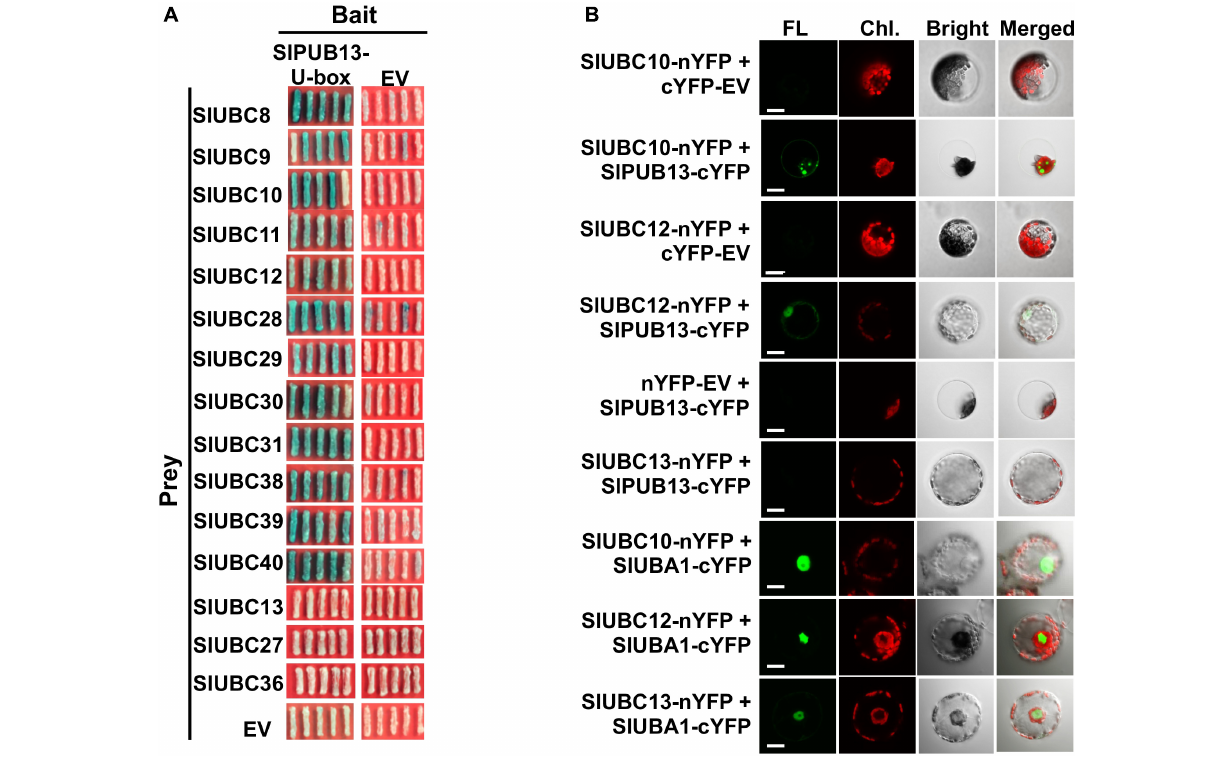
Frontiers in Plant Science |